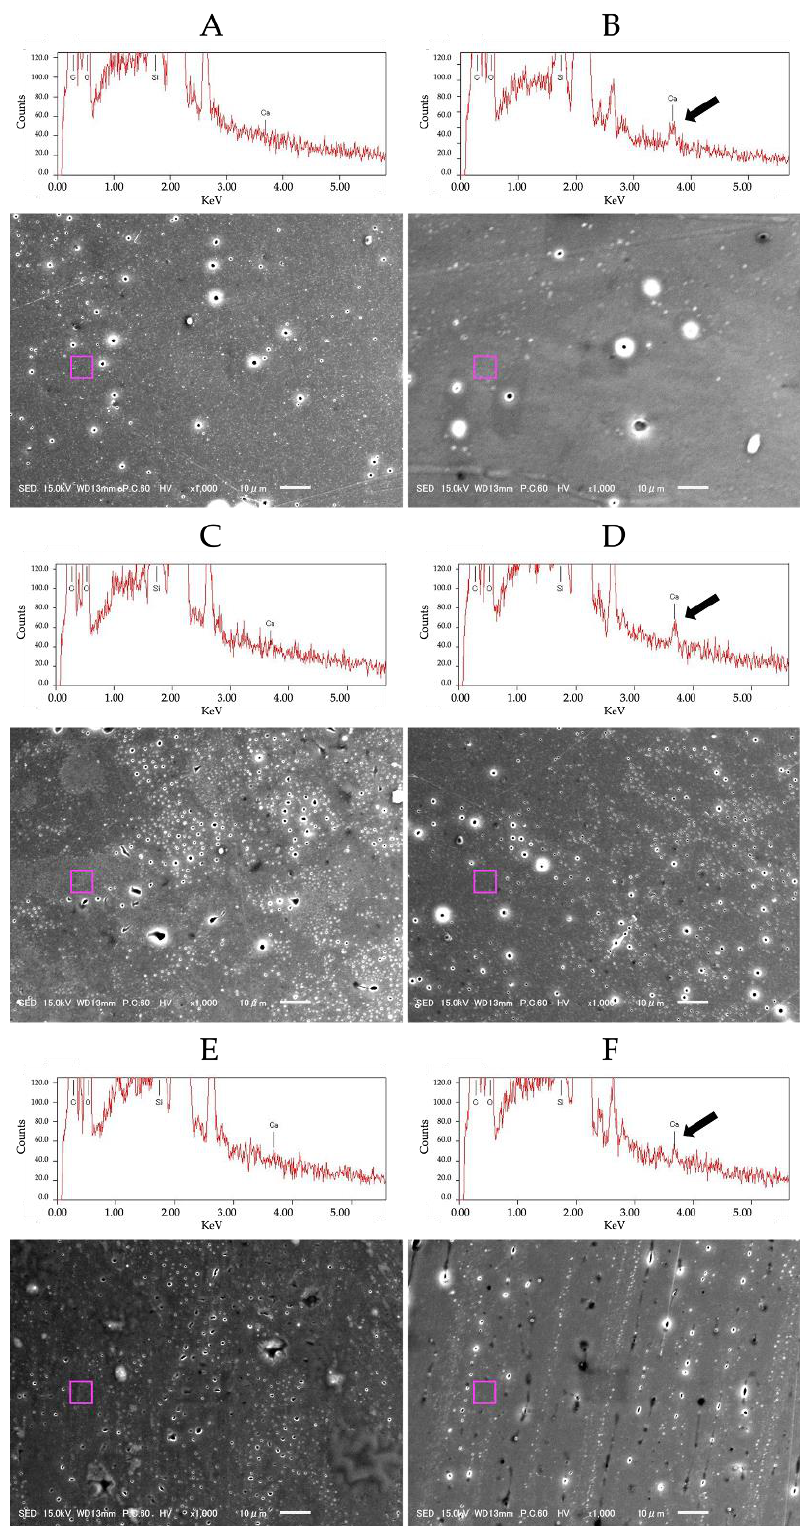
Figure 5. Representative SEM images of polymerized 1-SEAs specimens with related EDS spectrum. ( A ) SBU manipulated in TD, ( B ) SBU manipulated in HA, ( C ) UBQ manipulated in TD, ( D ) UBQ manipulated in HA, ( E ) UBQ exp manipulated in TD, ( F ) UBQ exp manipulated in HA. The pink squares indicate the location of the EDS analysis. The black arrow depicts the presence of calcium in the 1-SEAs manipulated in